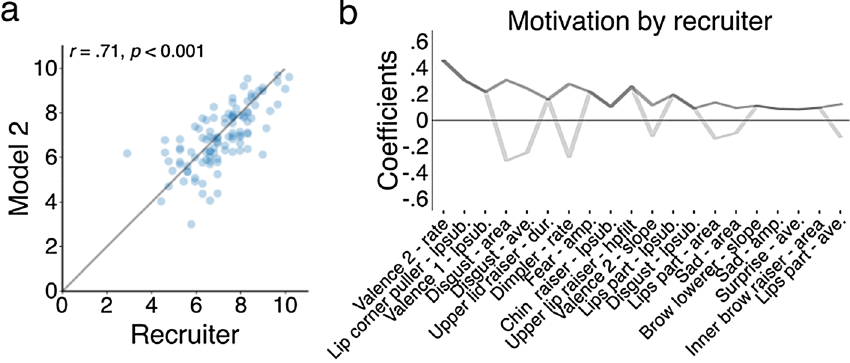
Figure 3. Predicting recruiter judgments. ( a ) Scatter plot correlation of motivation scores by recruiters (raters) versus CBMM. ( b ) Same as panel e in Fig. 2, but now for